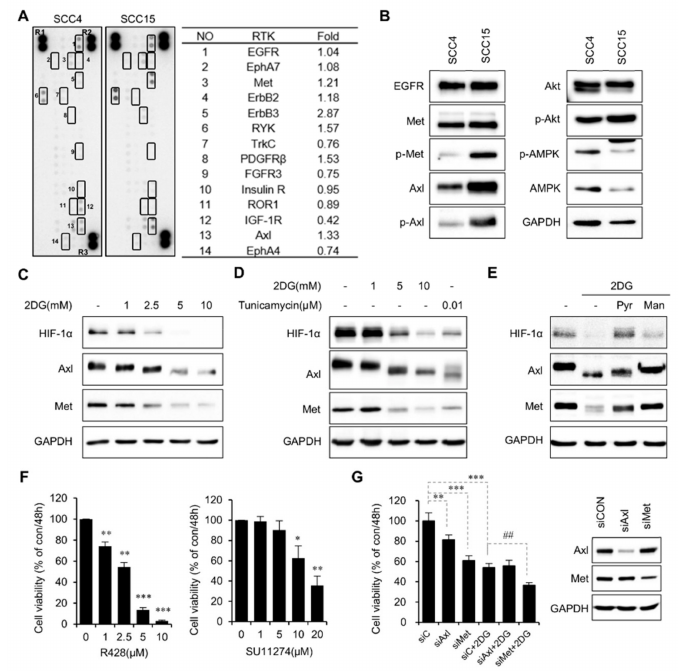
Figure 2. 2DG interferes with N-linked glycosylation of Axl and Met in SCC15